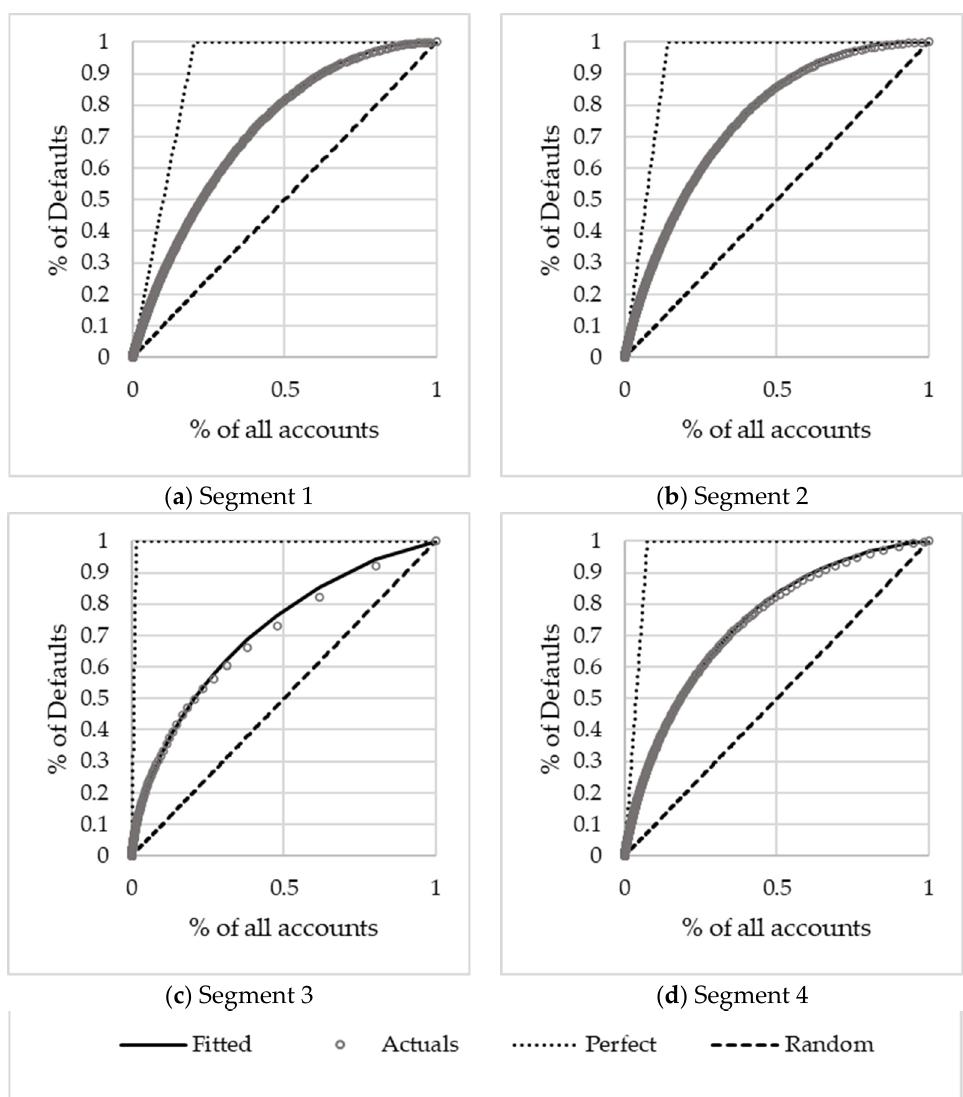
Figure 8. 22 month Lorenz curves.